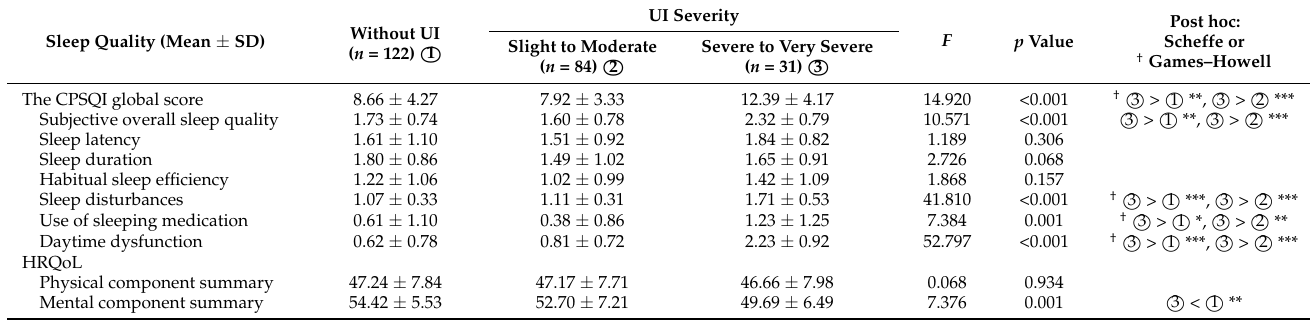
Table 3. Comparison of sleep quality and HRQoL by urinary incontinence condition ( n = 237).